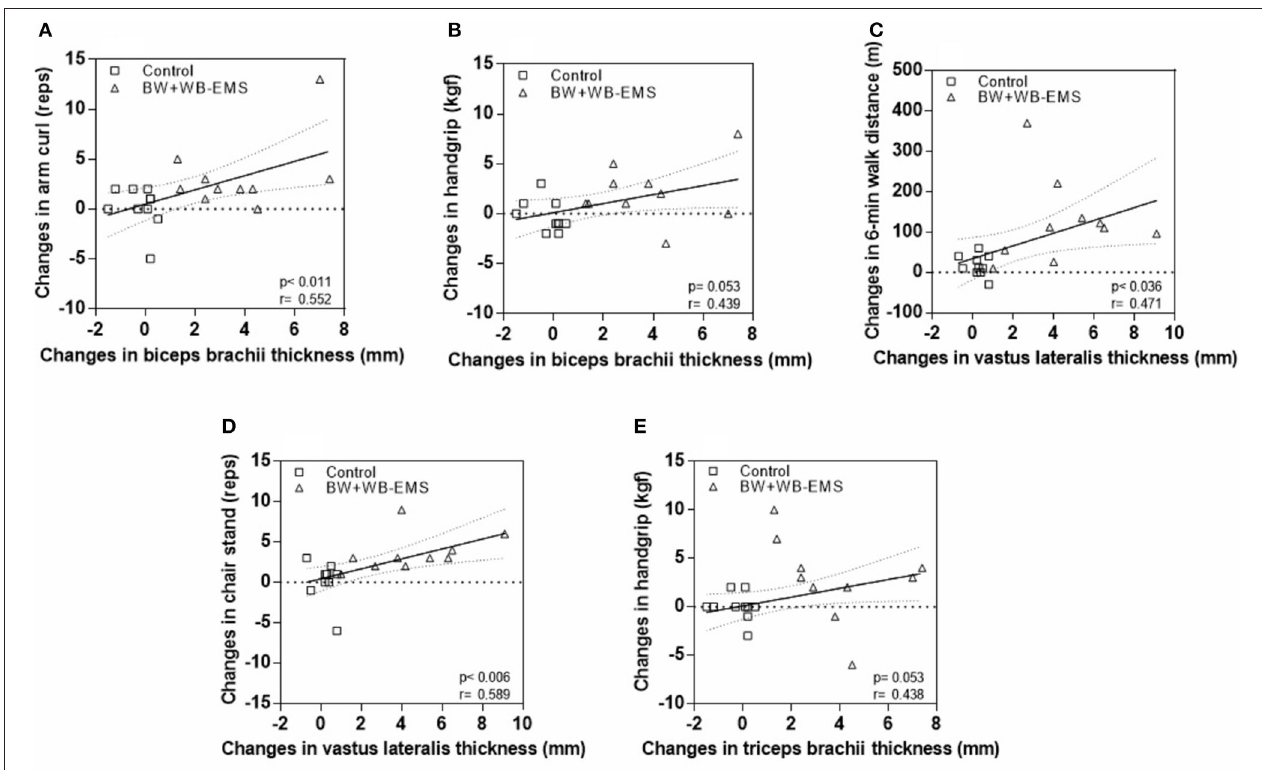
FIGURE 4 | Correlations between changes in functional fitness and muscle thickness parameters. (A) Changes in biceps brachii thickness and arm curl. (B) Changes in biceps brachii thickness and handgrip. (C) Changes in vastus laterais thickness and 6-min walk distance. (D) Changes in vastus laterais thickness and chair stand. (E) Changes in triceps brachii thickness and